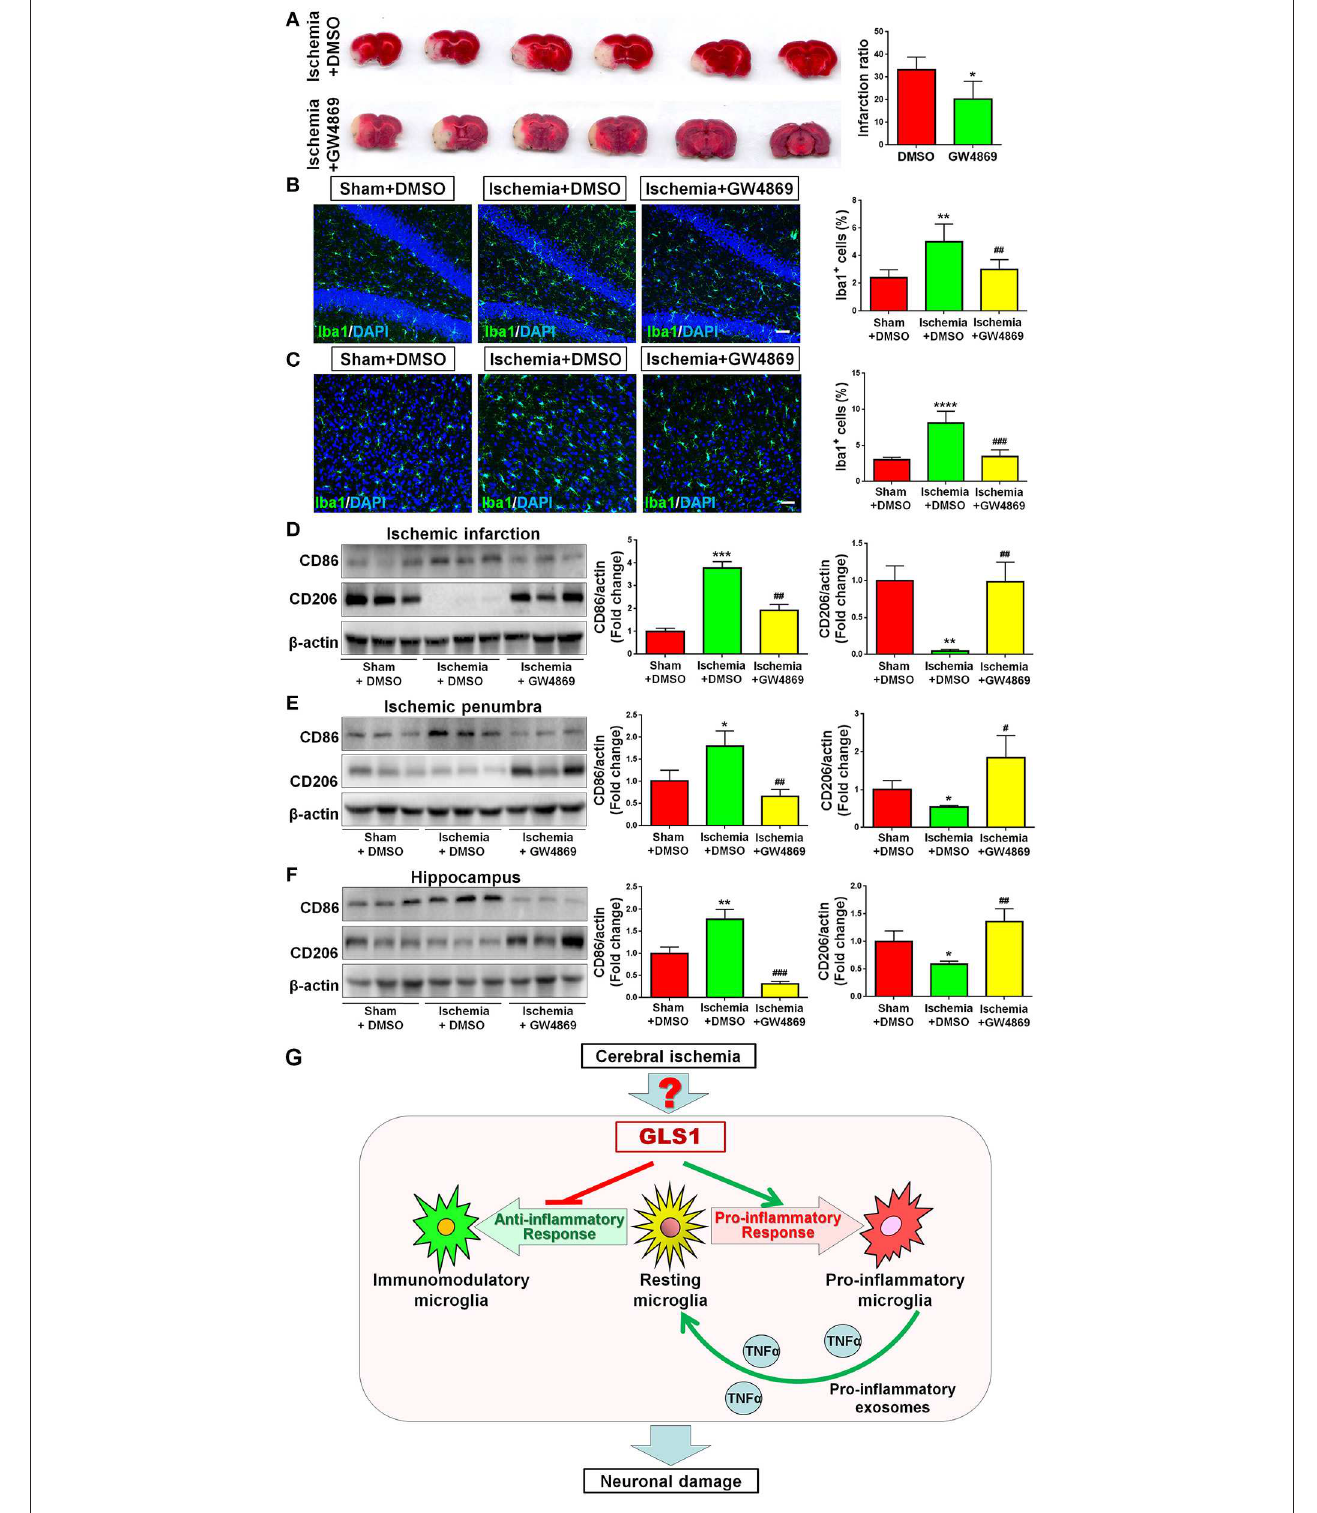
FIGURE 7 | Exosome release inhibition by GW4869 alleviates neuroinflammation. (A) TTC staining of rat brain serial coronal slices in sham, ischemia, and ischemia with GW4869 treatment groups. Infarction volume is given on the right panel. (B,C) Focal cerebral ischemic brains treated with or without GW48639 and their